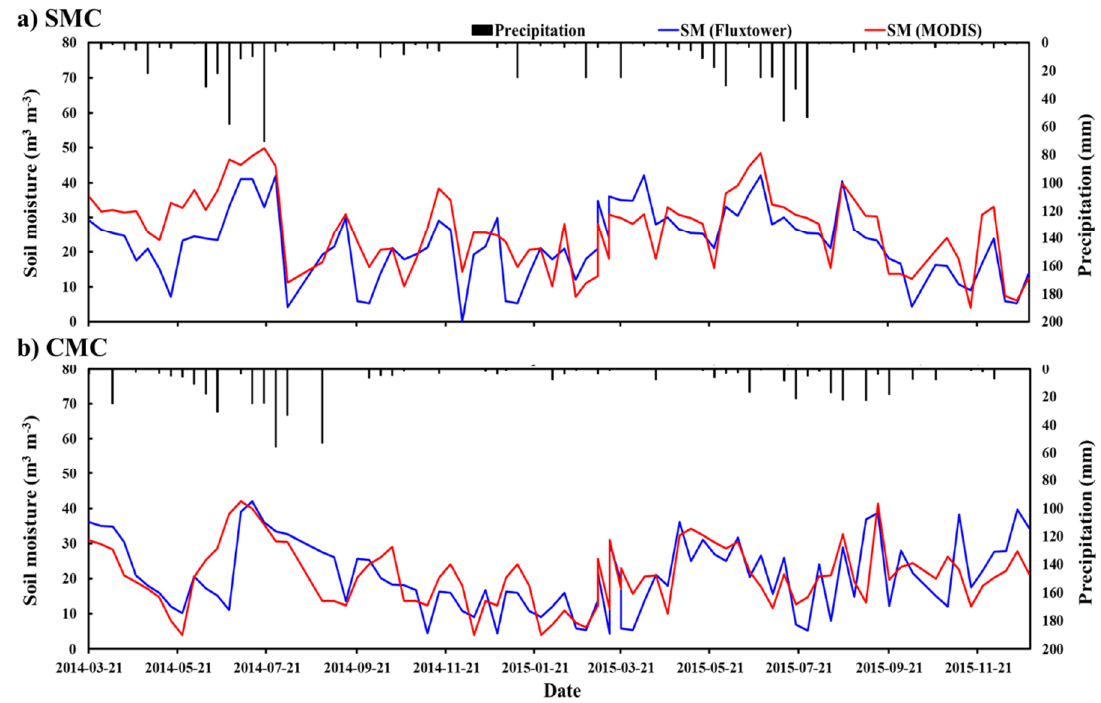
Figure 2. Temporal variations of average daily soil moisture at ( a ) Seolmacheon (SMC) and ( b ) Cheongmicheon (CMC) site.